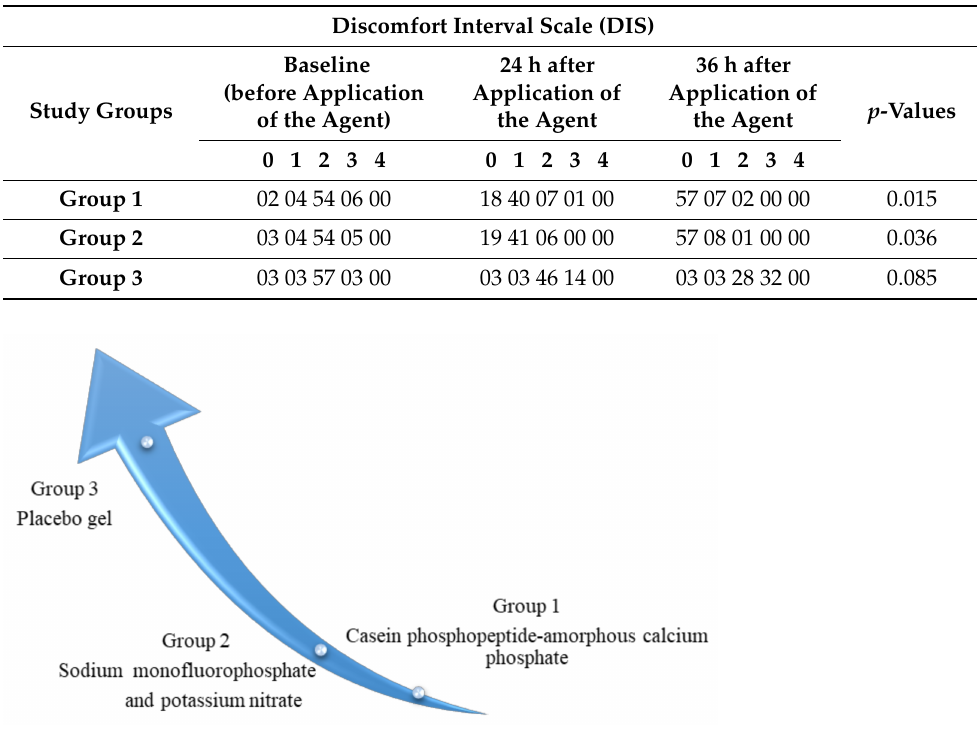
Figure 2. Illustration of pain severity in study groups, the upward extension of arrowhead suggests an increase in pain intensity between experimental and control